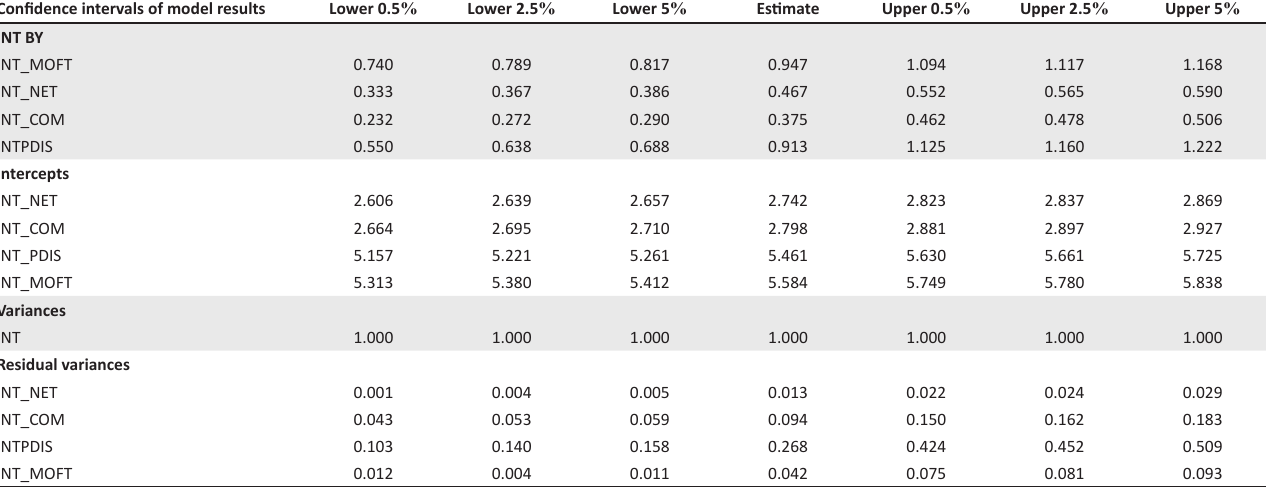
TABLE 1-A2: Bias-corrected bootstrap